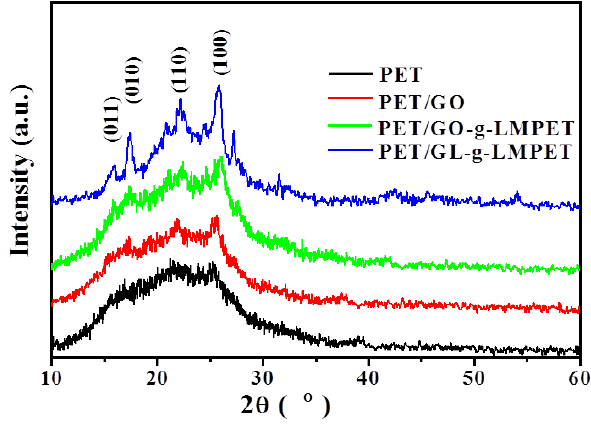
Figure 8. XRD curves of pure PET, PET/GO, PET/GO- g -LMPET and PET/GL- g -LMPET.